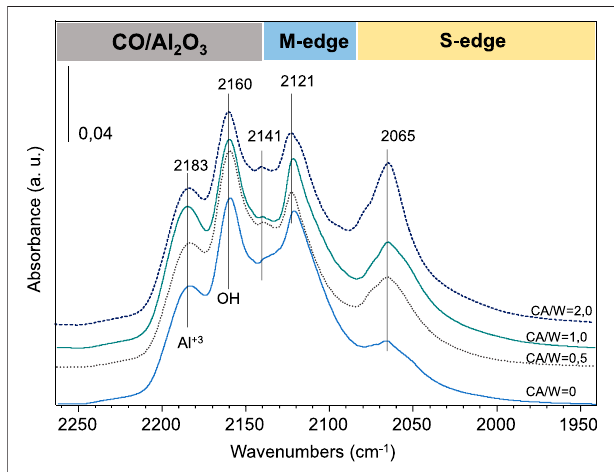
FIGURE 4 | IR spectra of CO adsorption (100 K, 133 Pa at equilibrium) on W (CA/W (cid:1) x)/Al 2 O 3 catalysts sul fi ded with 10%H 2 S/H 2 at 673 K and 0.1 MPa.